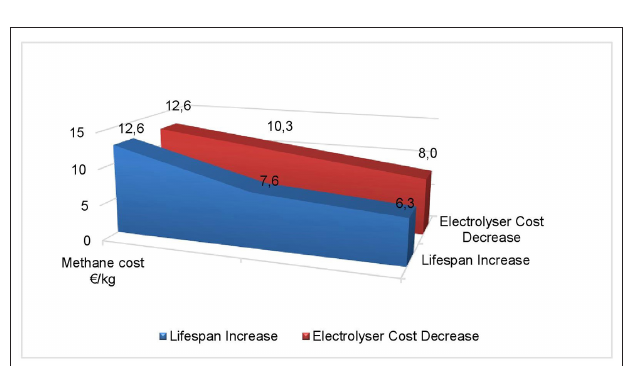
FIGURE 11 | Methane cost as a function of the electrolyzer’s lifespan and